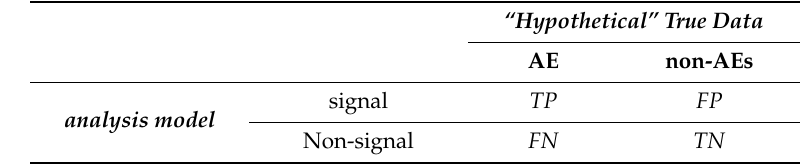
Table 2. Agreement between the criterion A and the “hypothetical” true data. AE: adverse event, TP : True Positive , FP : False Positive , FN : False Negative , TN : True Negative .